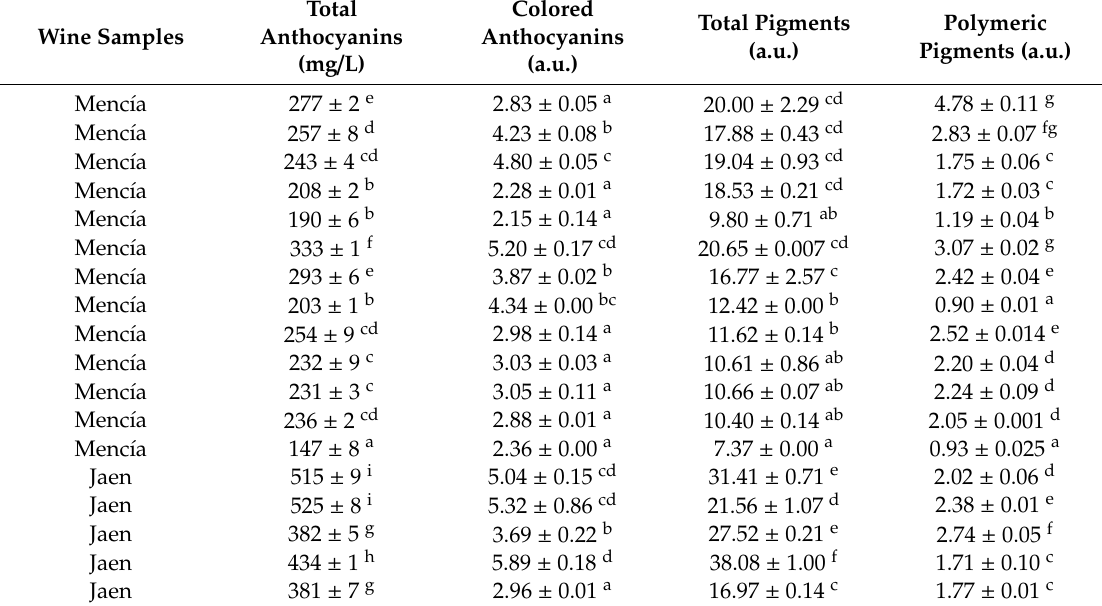
Table 5. ‘Menc í a’ and ‘Jaen’ red wines total anthocyanins, colored anthocyanins, polymeric, and total pigments. Wine Samples